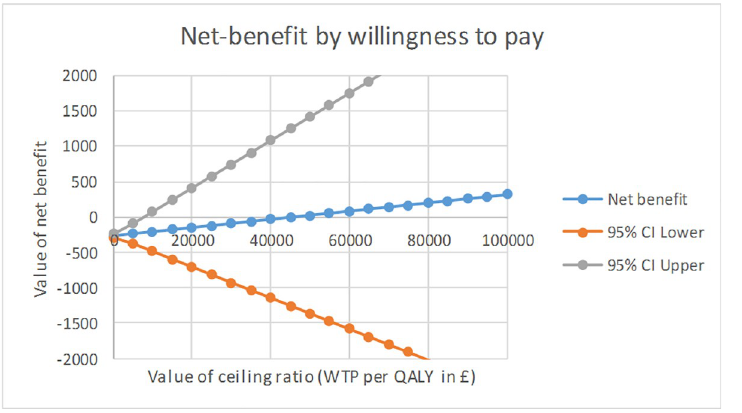
Fig 1. Net-benefit by threshold willingness to pay for an additional QALY.